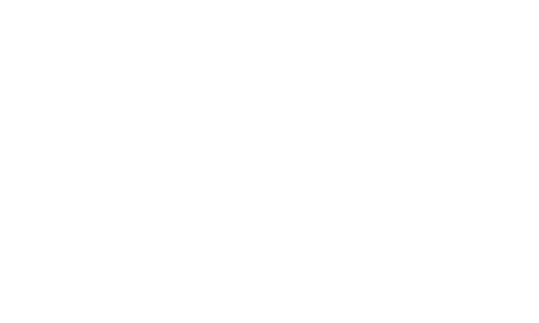
Table 1. Coefficients of the GLM model fitted to the full year rainfall quantity data (2000–2021).